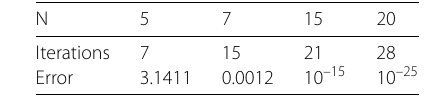
Table 2 Iterations and errors for Algorithm 2